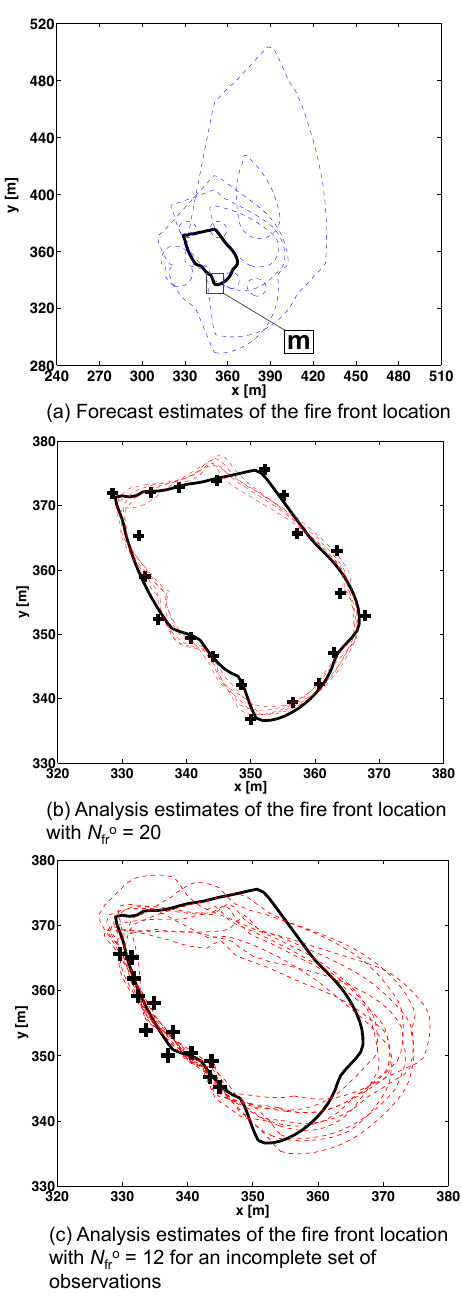
Figure 5. Spatially varying OSSE test with uncertain ROS model parameters and with uncertain ignition location ( x ign , y ign ); one assimilation cycle [0; 150s]; all figures correspond to the observa- tion time t = 150s. (a) Comparison between true (black solid line) and forecast (blue dashed lines) fire front positions. (b–c) Compar- ison between true (black solid line) and analysis (red dashed lines) fire front positions. Black cross symbols are the N os